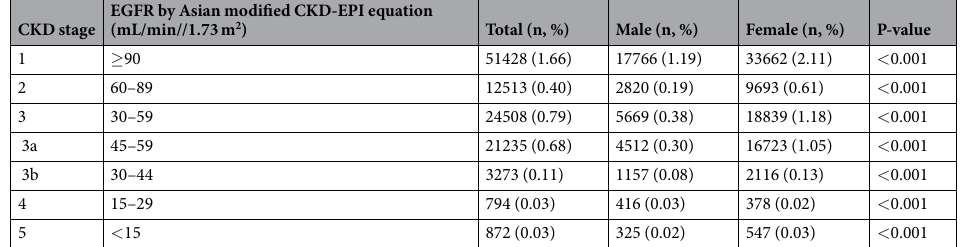
Table 2. Prevalence of CKD stages according to the eGFR in the married population with fertility desire in rural China by gender. CKD: chronic kidney disease. eGFR: estimated glomerular filtration rate.. CKD-EPI equation: chronic kidney disease epidemiology collaboration equation.